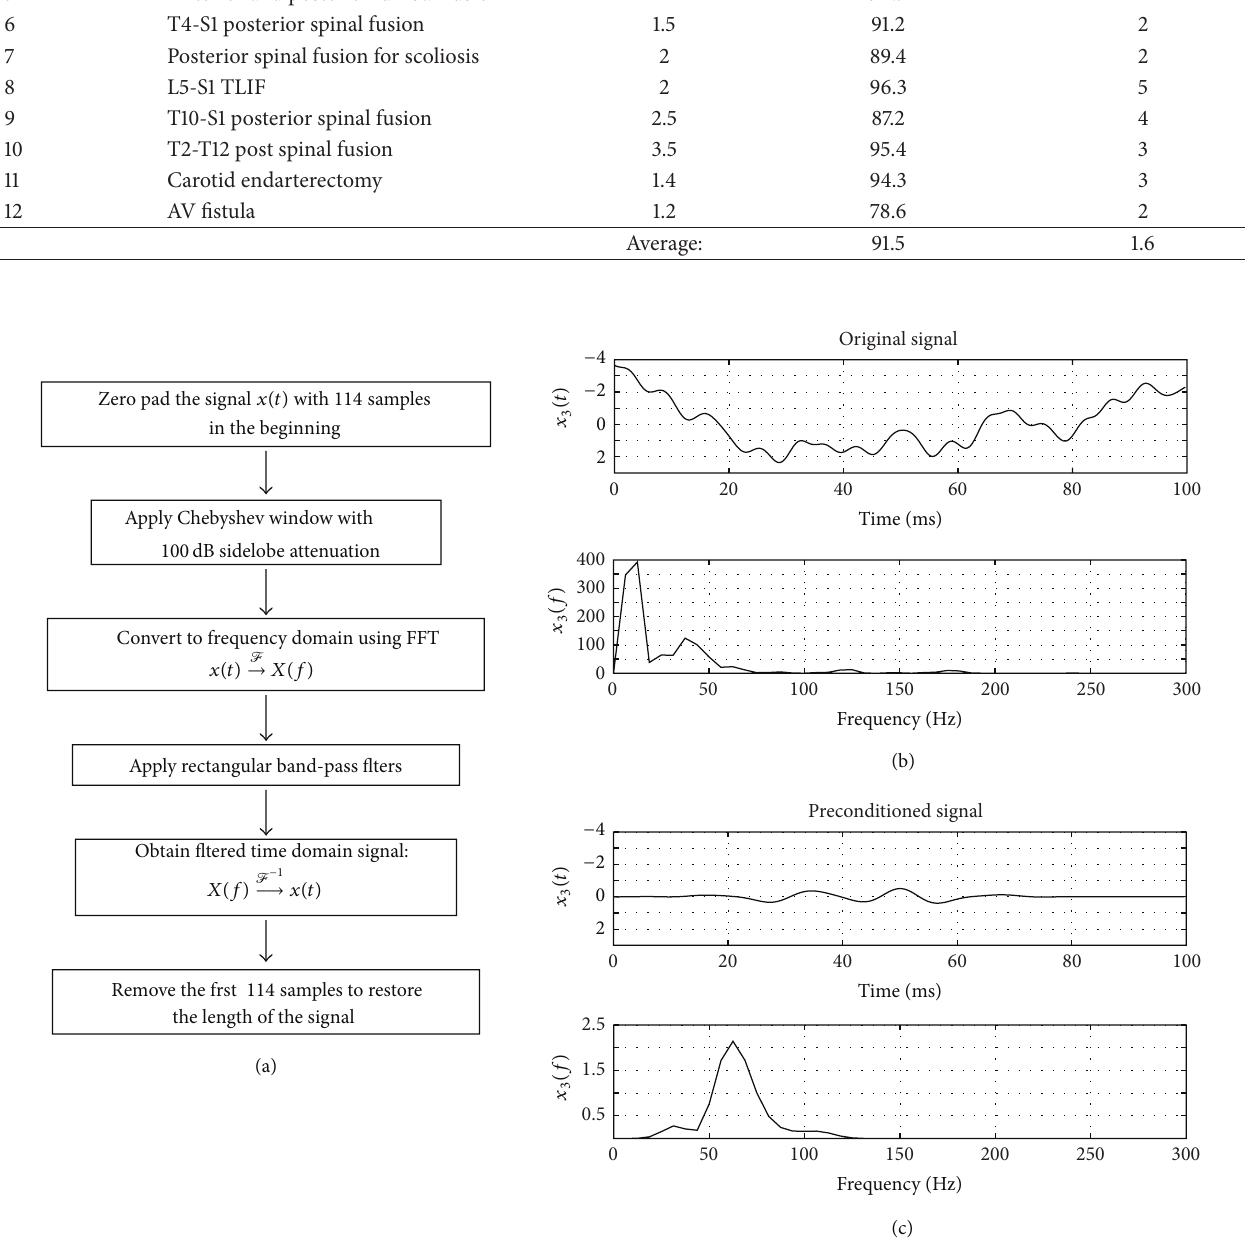
Figure 2: Diagram for “window based preconditioning.” (a) Algorithm flowchart for signal preconditioning. (b) The signal 𝑥 3 (𝑡) before pre- conditioning from Figure 1(b) along with its power spectrum. (c) The result of preconditioning the signal in (b) and its corresponding power